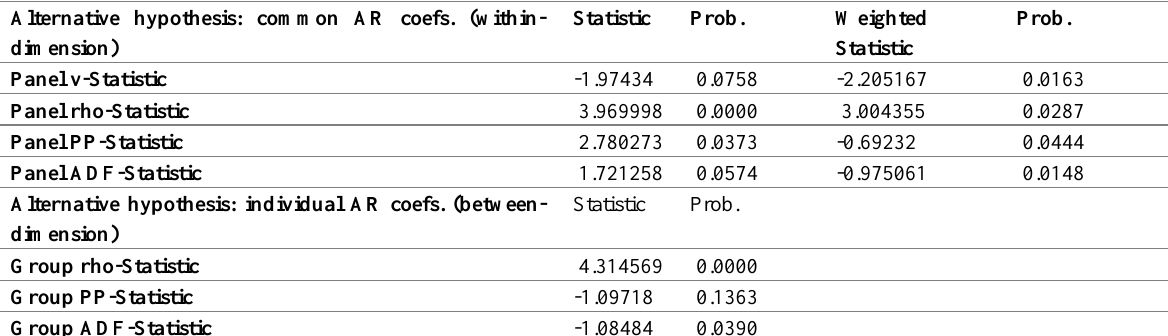
Table 3: Pedroni Panel Cointegration Test Without Trend